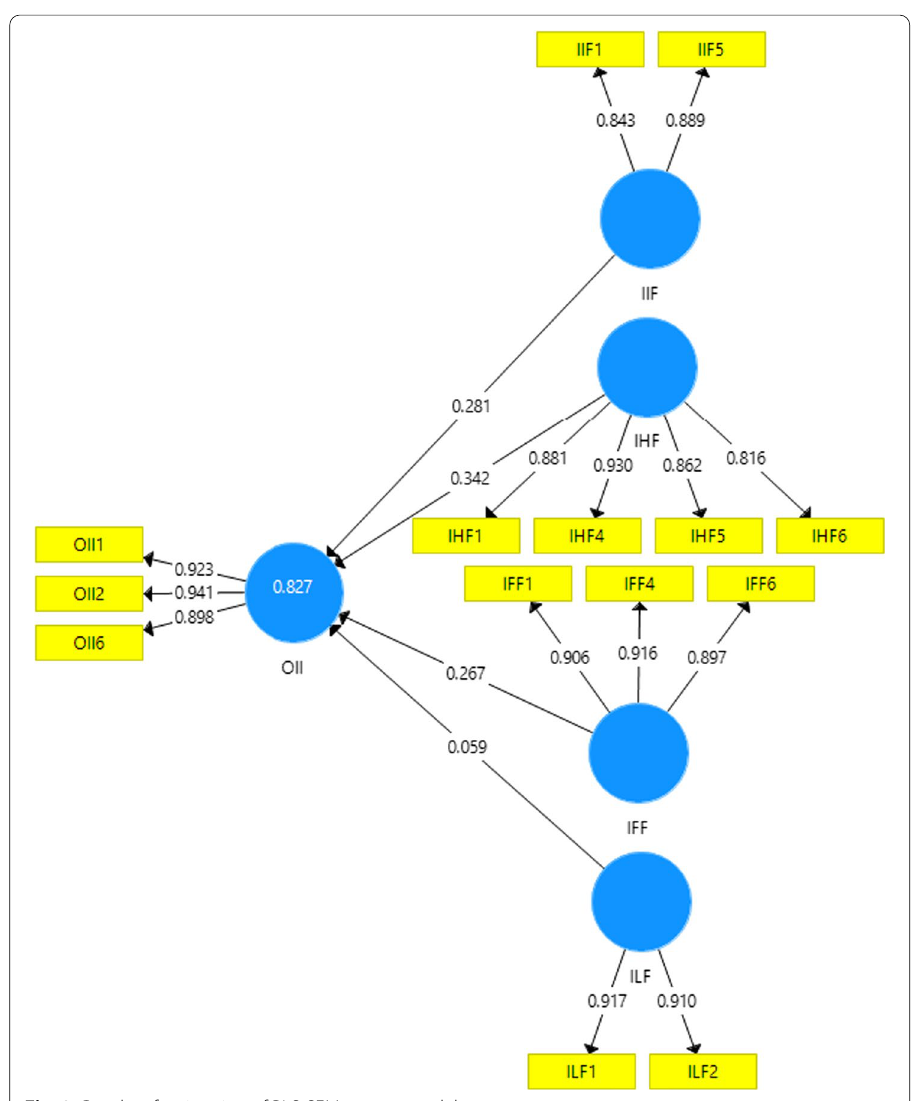
Fig. 2 Results of estimation of PLS-SEM 2015–2018